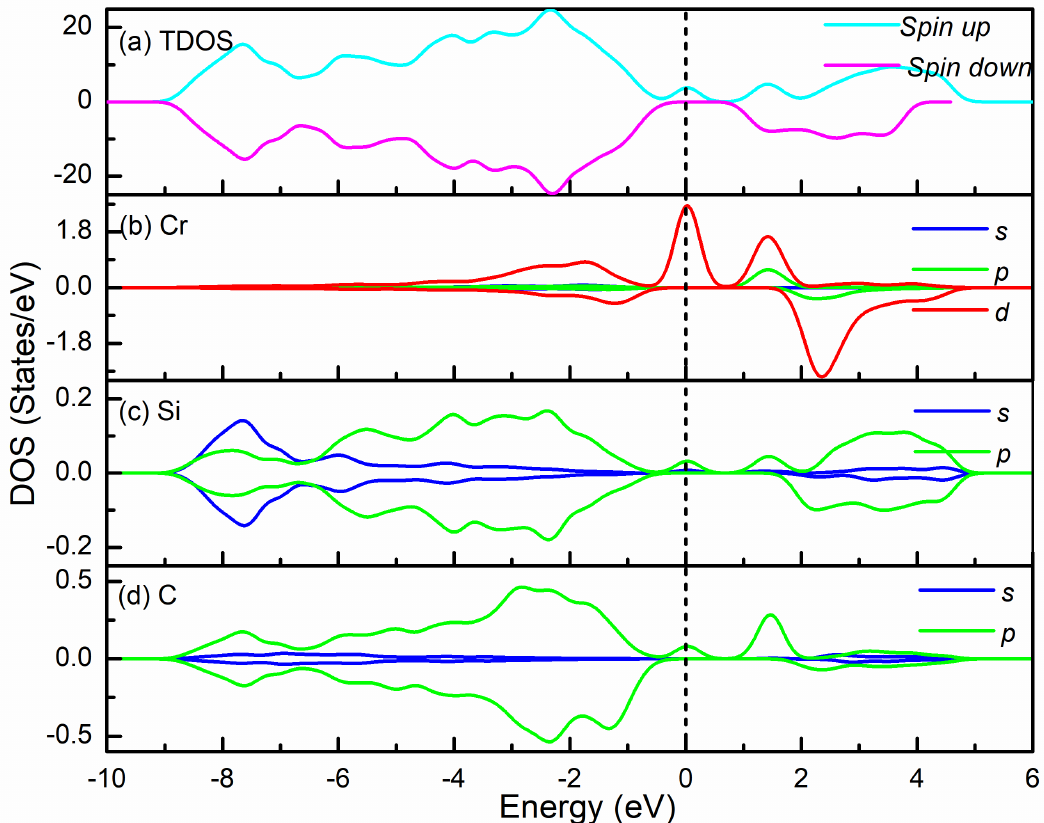
Figure 2. ( a – d ) The total and partial density of states (DOS) of Cr-doped 4H–SiC. The Fermi level is set to 0